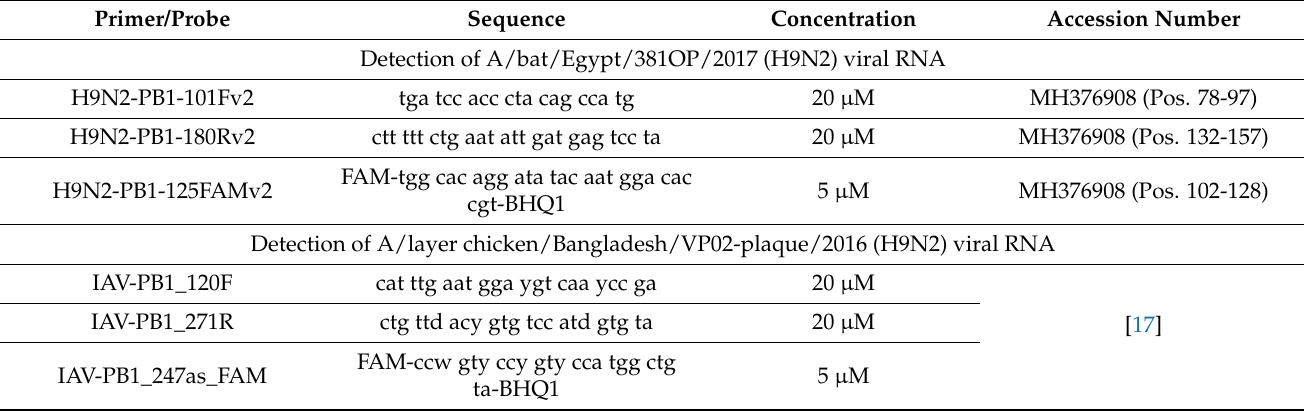
Table 1. Probes and primers for detection of A/bat/Egypt/381OP/2017 (H9N2) viral RNA (specifically designed for this study) and A/layer chicken/Bangladesh/VP02-plaque/2016 (H9N2) viral RNA. Primer/Probe